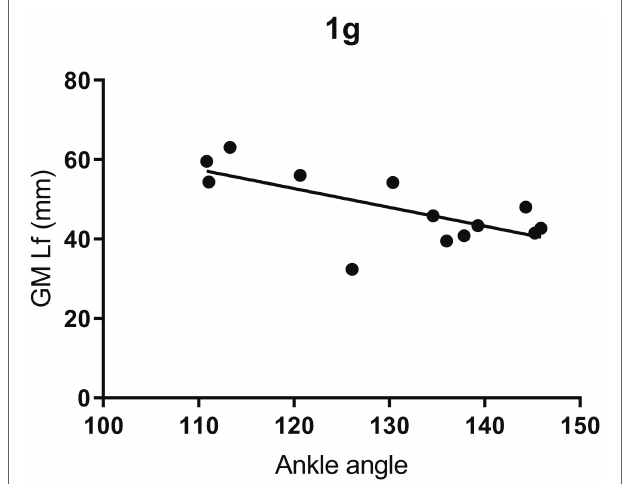
FIGURE 11 | Correlation between gastrocnemius medialis (GM) fascicle length (Lf) and ankle joint angle at drop-off (DO) in 1 g. Correlation parameters: p = 0.0103, r = −